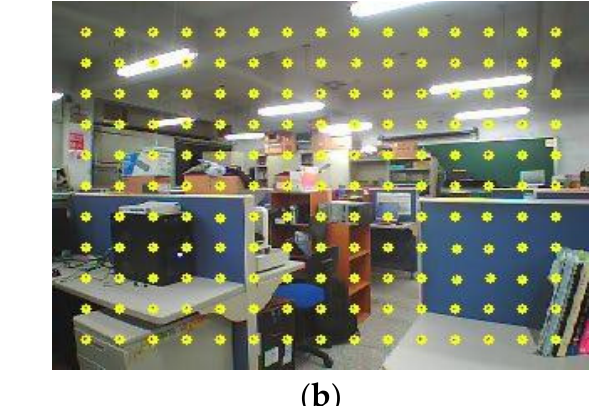
( b ) Figure 2. The tracking result of the KLT point on the blue board under the camera shake. ( a ) Uni- formly distribute points in the beginning; ( b ) tracking results after fifteen frames. Frame #1 Frame #4 Figure 3. The blue arrows denote the estimated optical flow vectors when the camera moves to the wall. We quickly redraw points uniformly every three frames. 2.2. Multi-Thread Processing The KLT tracker with high frequency of point uniformly redrawing brings the disad- vantage that identified optical flow is all erased when the tracked points are redrawn. At that time, the MUAV has no information to navigate the MUAV for obstacle avoidance. Here, a multi-thread processing for continuously obtaining the optical flow information is proposed to solve this problem. As shown in Figure 4, multiple threads are set to exe- cute the pyramid Lucas–Kanade algorithm at the same time, and the point redrawing time of each thread is different. Assuming that there are N